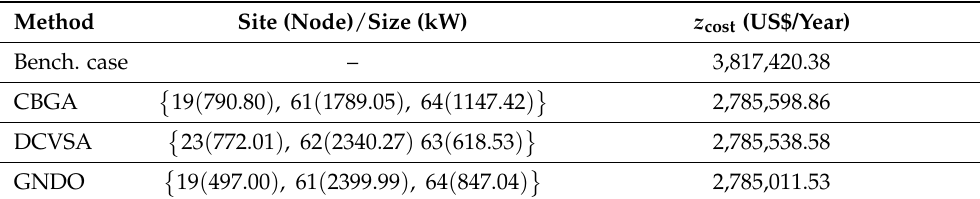
Table 5. Application of the GNDO approach to the location and sizing of PV generation in the 69-bus grid and comparison of results with literature